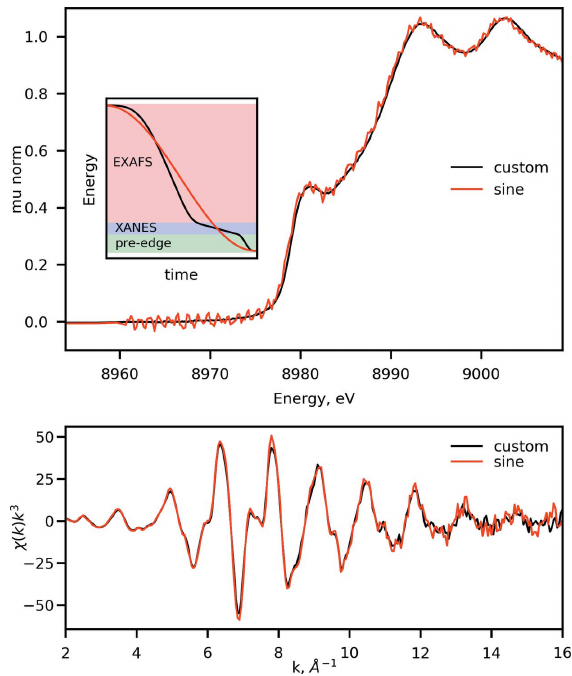
Figure 8 Comparison of the data recorded using the trajectory designed at ISS and sinusoidal motion common at fast scanning XAS beamlines. The data are measured during energy scan down with duration 1 s on copper foil at the Cu K -edge at 8979 eV. (Top) Comparison of the processed data in the XANES region. The inset shows a qualitative comparison between the custom trajectory and the sine trajectory with the depiction of the energy regions covered as a function of time. (Bottom) The k 3 -weighted (cid:4) ( k ) function obtained after normalization and background removal of the processed absorption spectra measured using the two trajectories.